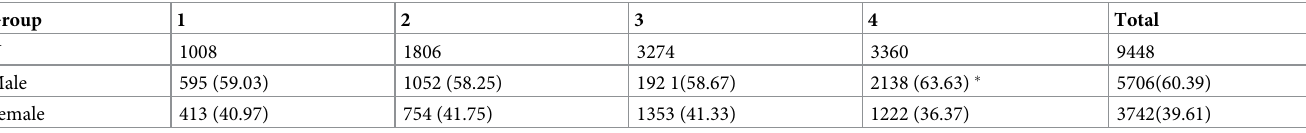
Table 1. Comparison of gender composition of each